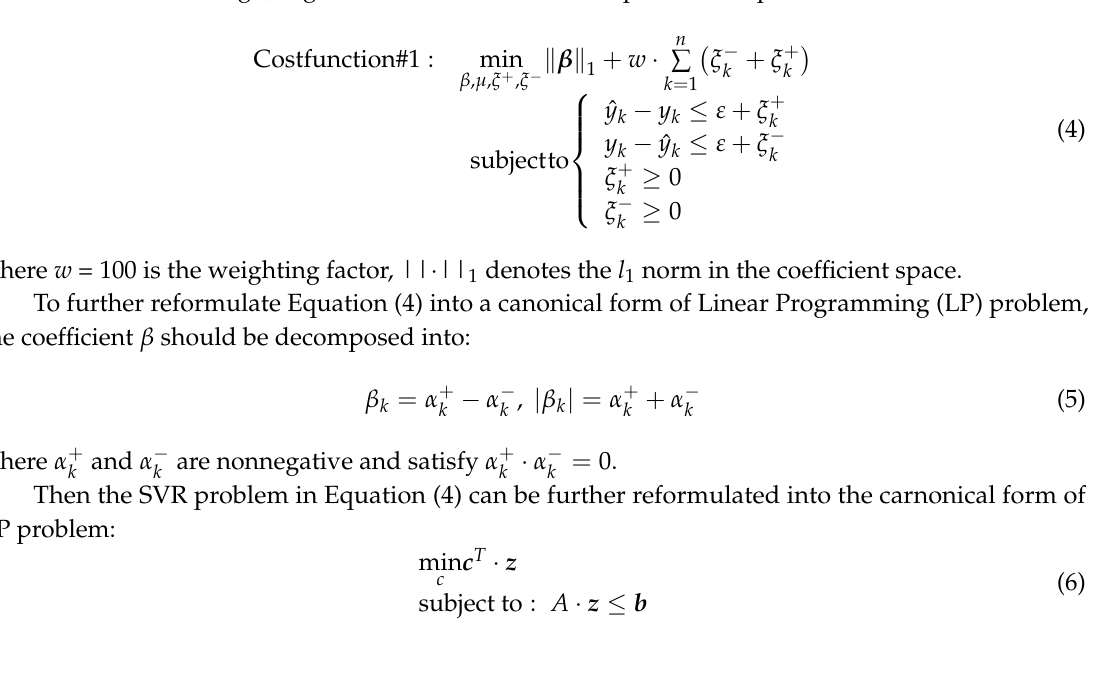
for support vector and ξ − k k